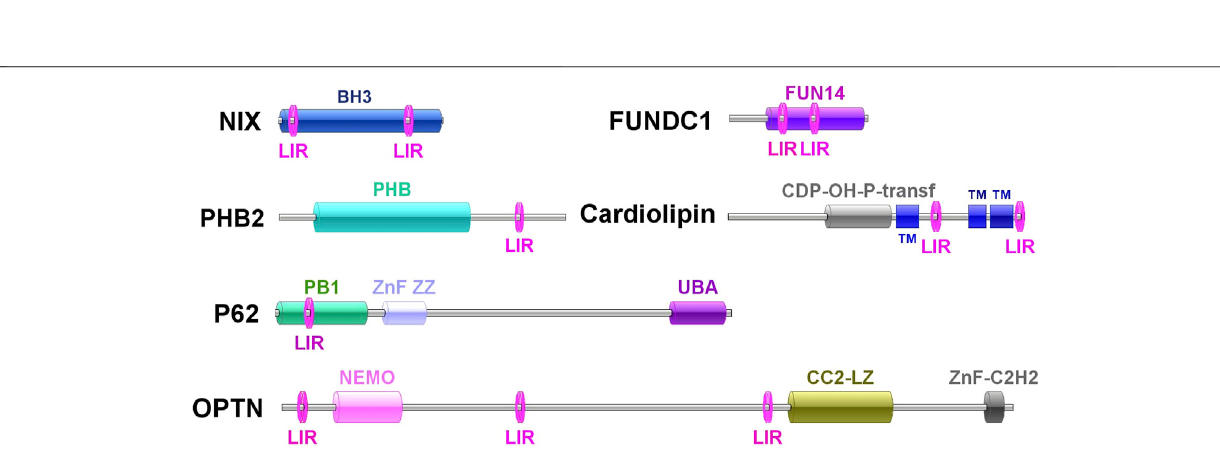
FIGURE 2 | Molecule features of Cg NIX, Cg FUNDC1, Cg PHB2, Cg Cardiolipin, Cg P62, and Cg OPTN and their LIR